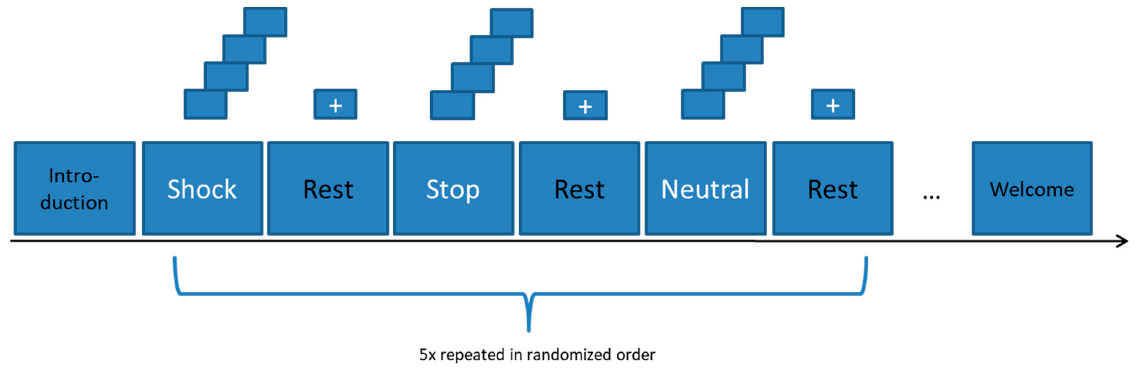
Figure 2. Experimental Design of the fNIRS experiment. A block design with three experimental conditions (“Shock”, “Stop”, and “Neutral”) was used. The order of the trials was randomized.